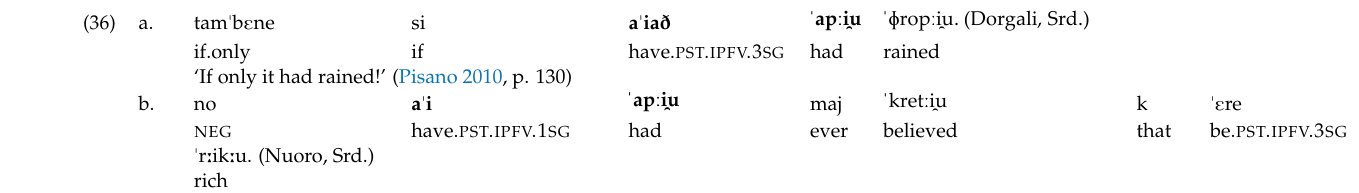
Alongside the unmarked structure in (35a) in which the counterfactual reading is expressed by a single layer of ‘fake’ tense in the form of the imperfect past form of the auxiliary alone, we also find the marked strategy in (35b) with two layers of ‘fake’ past realized through a surcomposé (viz. doubly compound) form in which the finite auxiliaries fis ‘were’ and aíamos ‘had’ are reinforced by corresponding participial forms istatu ‘been’ and áppitu ‘had’. As noted in the literature (Pittau 1972, pp. 112, 156f.; Jones 1993, p. 83; Pisano 2010; 2016; Loporcaro 2016, p. 818; Mensching and Remberger 2016, pp. 285, 288), these forms are limited to past counterfactual conditionals such as (35a–b) and other past irrealis contexts such as unrealized wishes (36a) and main-/embedded-clause conditional perfects (36b; cf. Pisano 2010, p. 129f.), but are excluded from realis contexts and compound paradigms outside of the pluperfect (cf. Pisano 2010, p. 125). 18